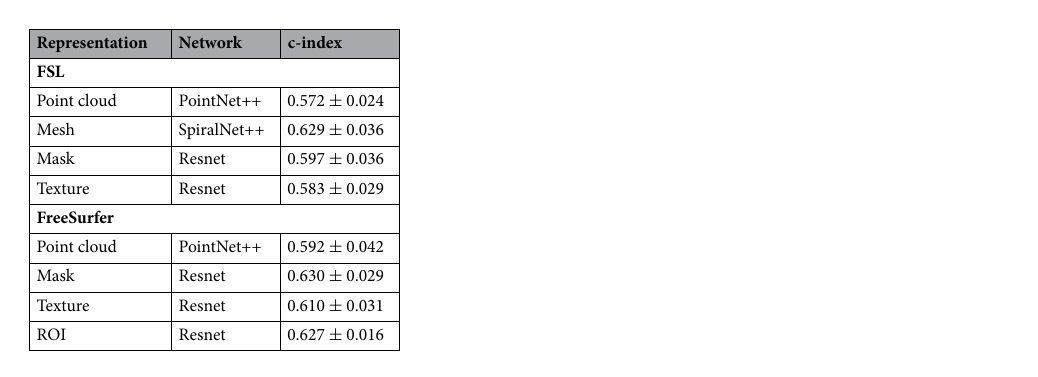
Table 2. Time-to-dementia prediction performance on ADNI for different representations. Top: Segmentations obtained using FSL FIRST software. Bottom: Segmentations obtained using FreeSurfer